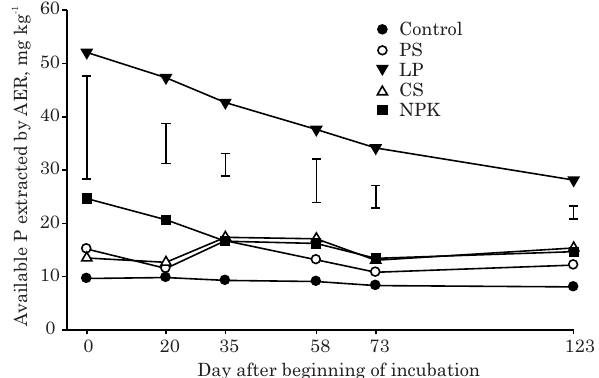
Figure 1. Phosphorus contents extracted by anion exchange resin (AER) in a Typic Hapludalf treated with nutrient sources and incubated for 123 days. The vertical bars represent the least significant difference between the mean values of each treatment (Tukey test at 5